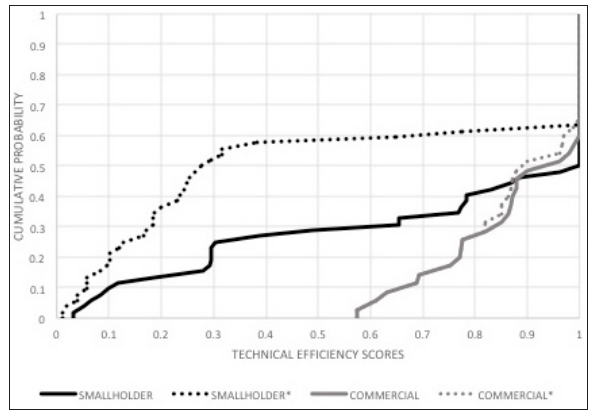
Cumulative probability for the group frontiers (solid lines) and technical efficiency relative to the metafrontier (broken